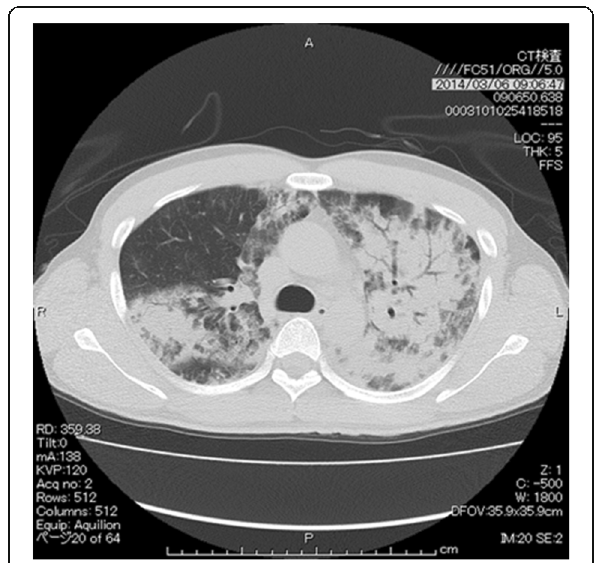
Fig. 2 Computed tomography (CT) scan of the lung. CT images showed bilateral infiltration and air